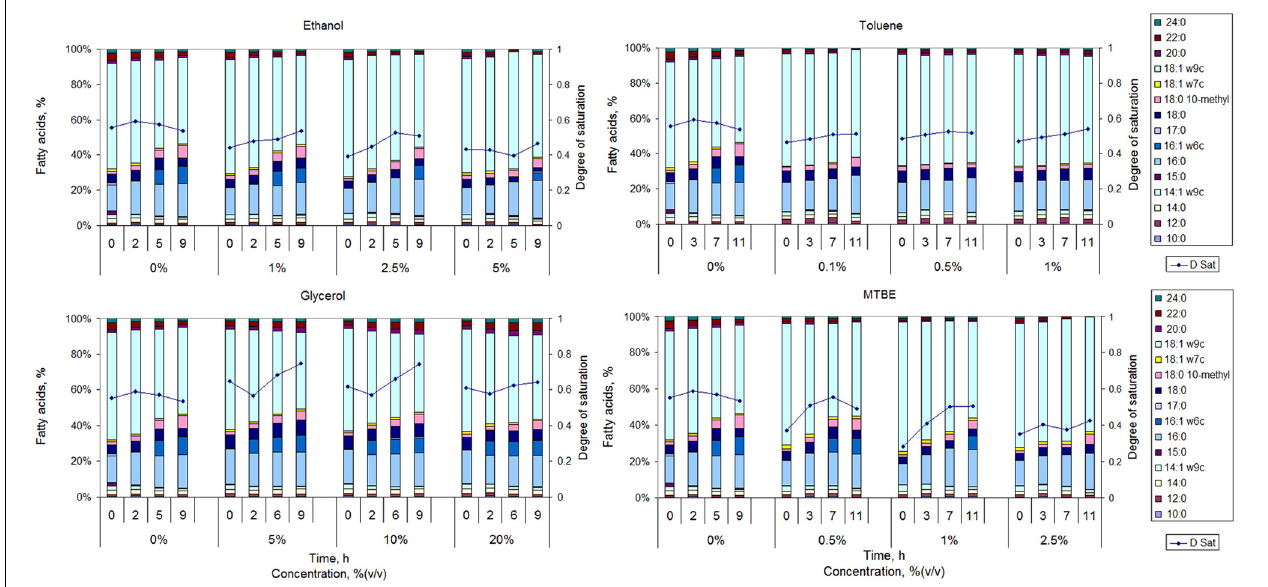
FIGURE 2 | Fatty acid composition and respective calculated degree of saturation (D Sat) of M. vaccae cells grown in the absence of organic solvents and in the presence of ethanol, glycerol toluene, and